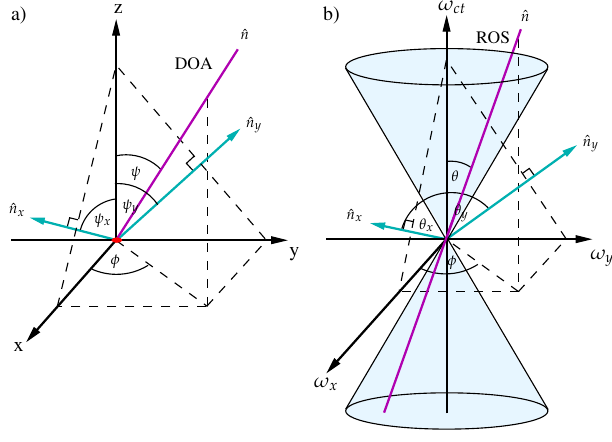
Figure 2. The graphical analogy of an incident plane wave. ( a ) Incident plane wave in 3-D space domain used to derive the cascaded 2-D beam filters and ( b ) 3-D space-time domain.